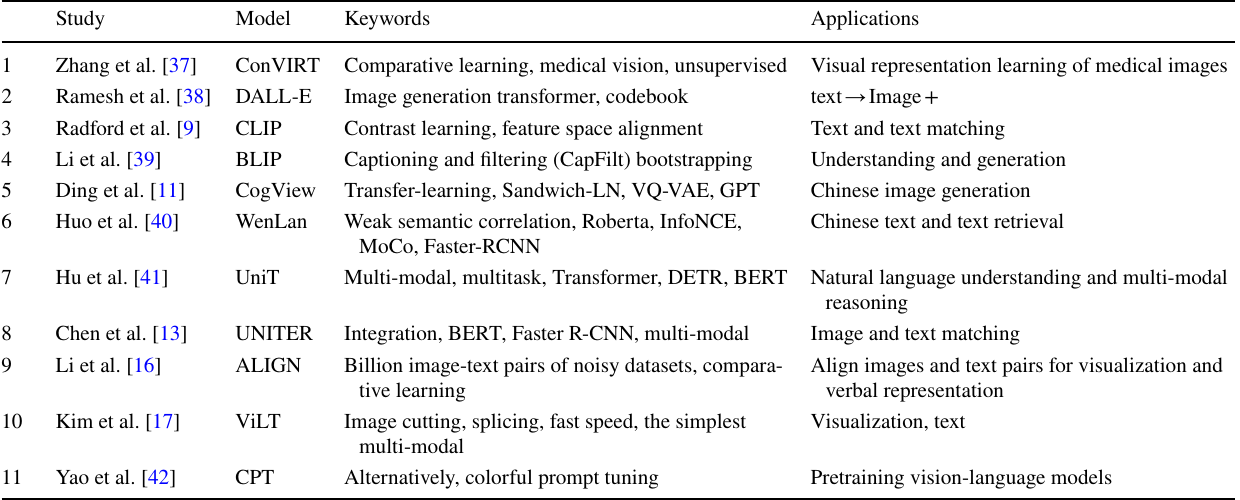
Table 1 Mainstream multi-modal pre-training